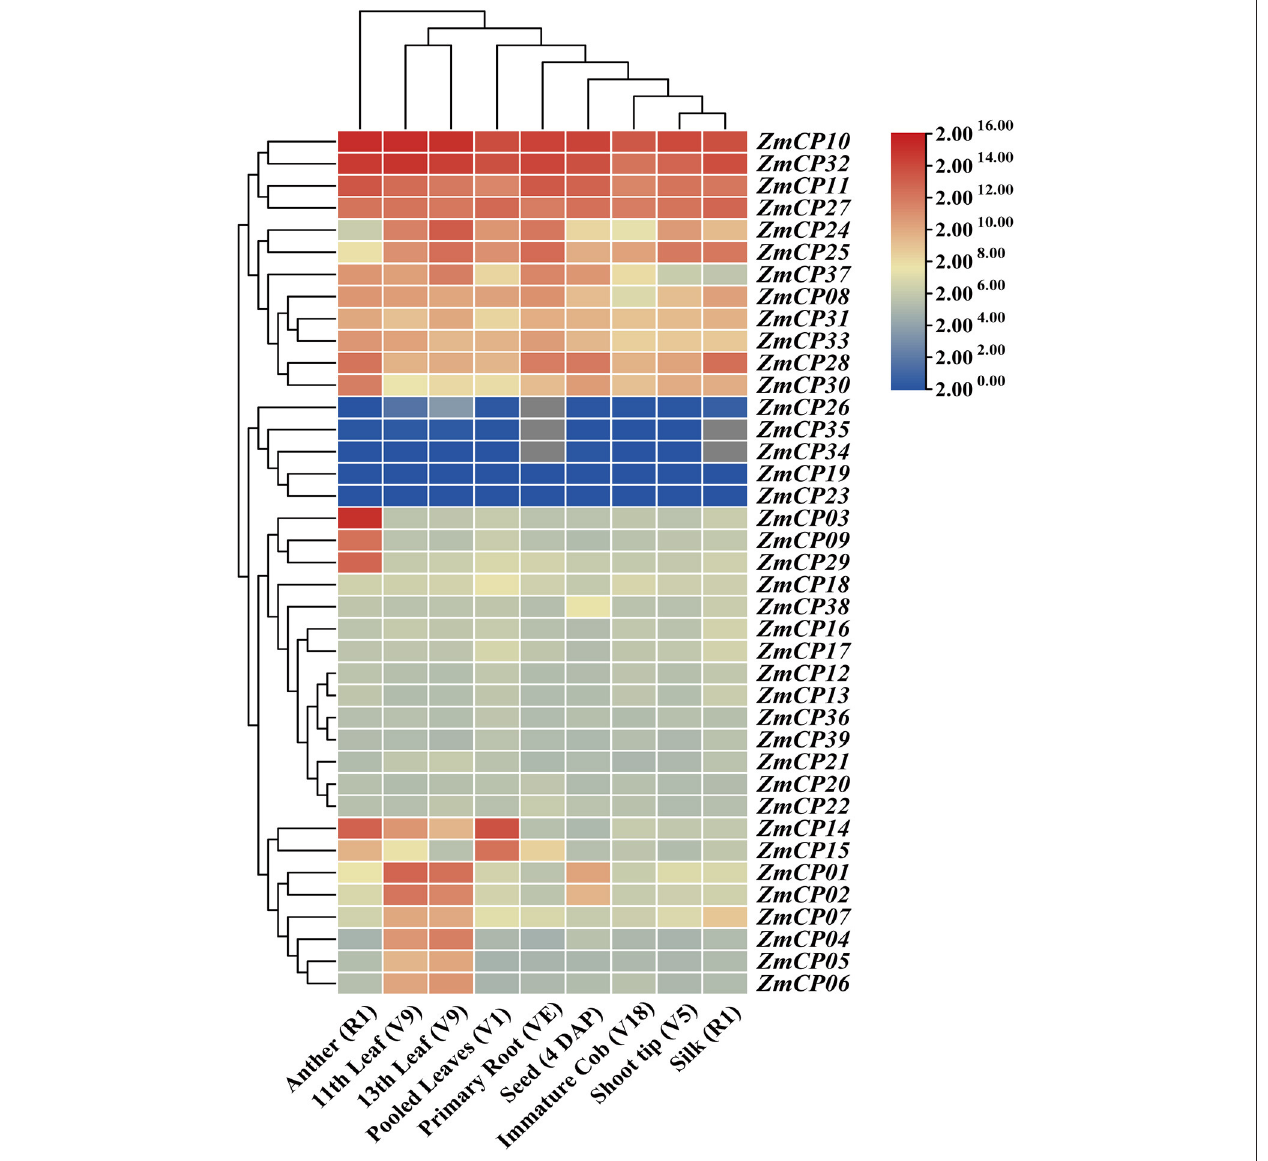
FIGURE 5 | Heatmap of ZmCP genes expression levels in maize. R1: silking stage; VE: vegetative emergence; V1, vegetative 1st leaf stage; V5, vegetative 5th leaf stage; V9, vegetative 9th leaf stage; V18, vegetative 18th leaf stage; DAP, days after pollination.